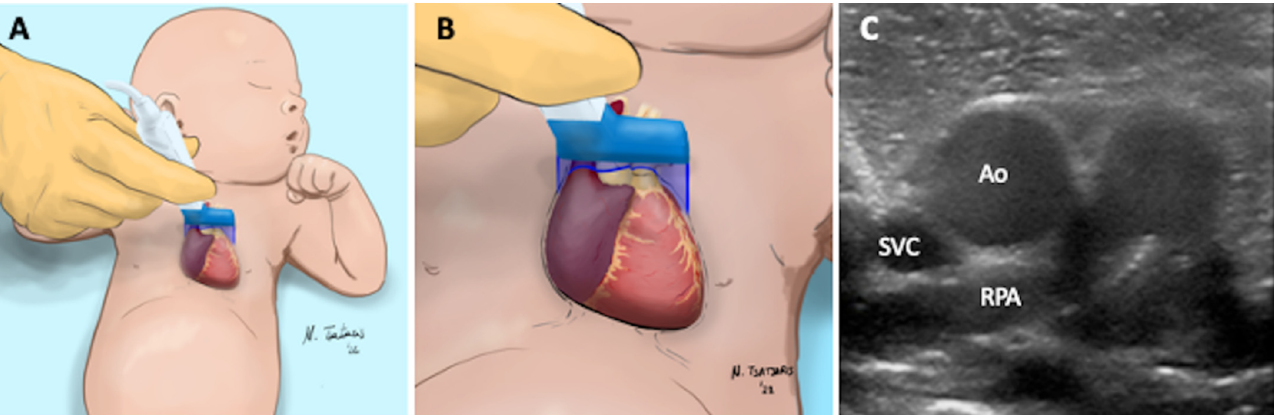
Figure 3. Spectral Doppler profile of blood flow velocity in the SVC, assessed from a suprasternal view. The green line represents the peak blood flow velocity, the white line the mean blood flow velocity.